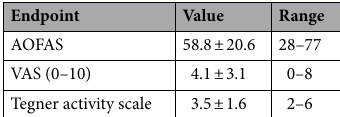
Table 2. Main results at last follow-up.